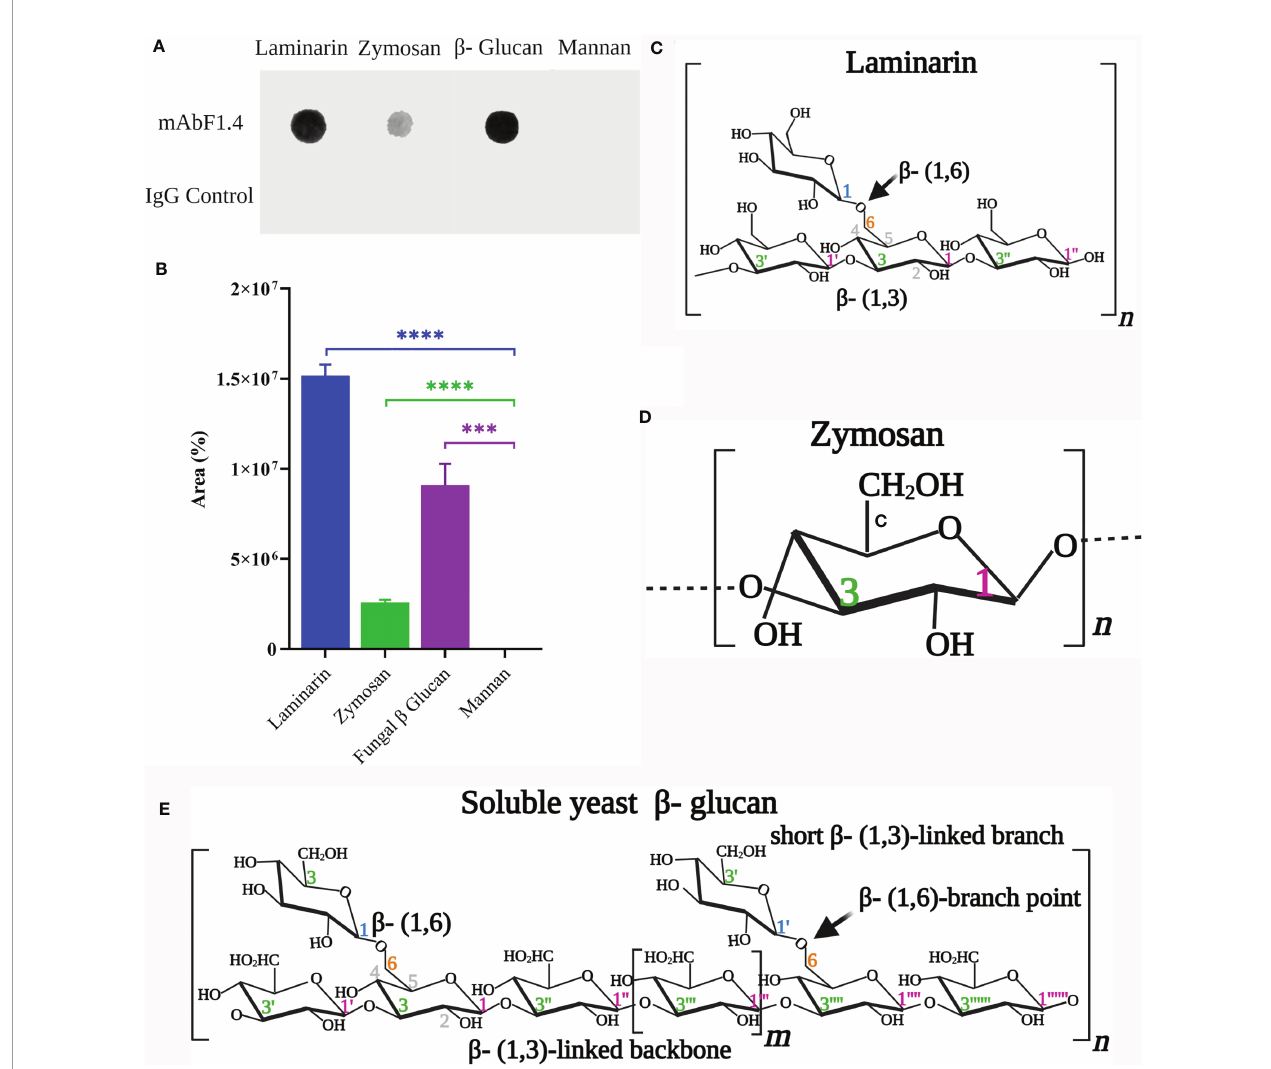
FIGURE 1 | Partial identi fi cation of the mAbF1.4 epitope. (A) Dot blotting: samples (100 m L) of laminarin (0.1 m g/ m L), zymosan (0.1 m g/ m L), yeast mannan (0.1 m g/ m L) and soluble b -glucan extract from Saccharomyces cerevisiae were tested with mAbF1.4 (10 m g). An IgG control (10 m g) was used as a negative control. An anti- mouse IgG Horseradish Peroxidase at 1:2500 dilution was visualized with Peroxide and immediately imaged in a documentation system. The dark spots in Laminarin, Zymosan and soluble b -glucan extract reactions with mAbF1.4 evidence antibody- antigen complexes. (B) Dot Blot Quanti fi cation analysis using the gel analysis tool on ImageJ for determination of area. Data were presented as mean ± SEM and analyzed with the two-tailed Student ’ s t-test between each polysaccharide and the Mannan values, since mAbF1.4 does not bind Mannan. Representation of the structures of (C) Laminarin, (D) Zymosan and (E) Soluble yeast b -glucan, all modi fi ed from Waszkiewics- Robak (27) and created with Biorender.com. ***p: 0.0003; ****p <